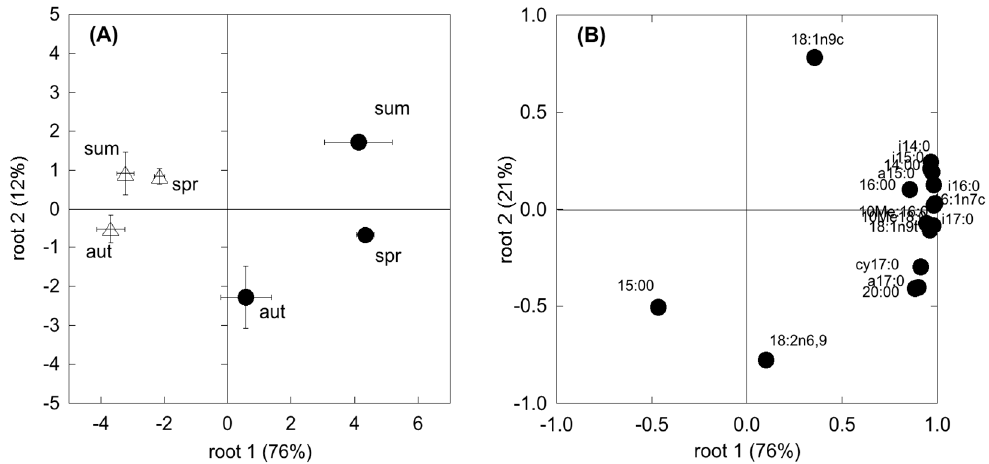
Figure 7. Principal Component Analysis (PCA) of microbial population structure based on the EL-FAME profiles. ( A ) Factor coordinates of cases: empty triangles = WDS, full circles = SDS; Spr = Spring; sum = Summer; aut = Autumn; ( B ) factor loadings of variables; for labels see Table A3.